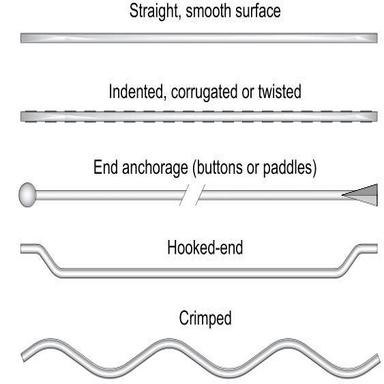
Most common fibre shapes.